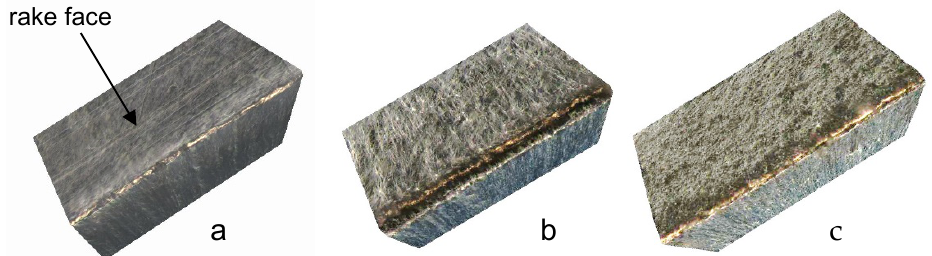
Figure 3. 3D image of cutting edge of planer knife without the coating after sharpening ( a ), the cutting edge of planer knife without the coating ( b ), and with CrCN/CrN multilayer coating ( c ) after 6000 m of dry beech wood cutting [83].